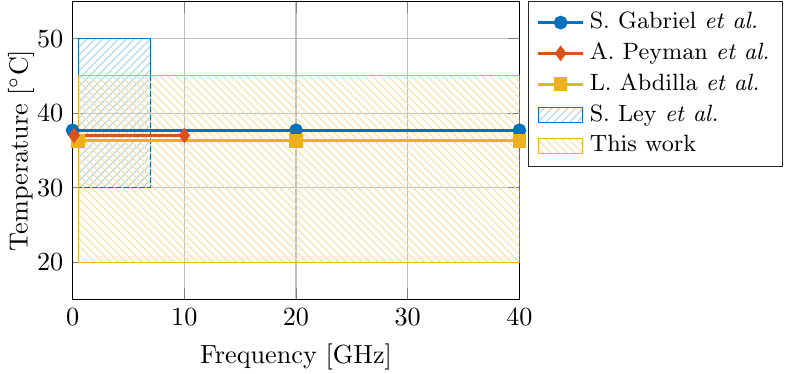
Figure 1. Comparison of the operating temperature and frequency range of dielectric models for muscle tissue [19,22–24] from state-of-the-art